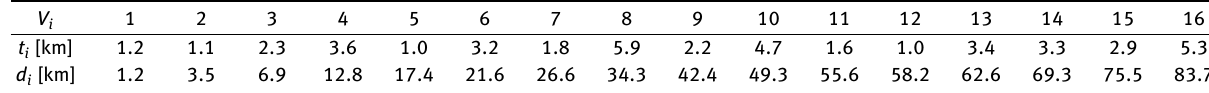
Table 1: Calculation of the d i parameter based on distances between V 0 and V i for single AGV V i